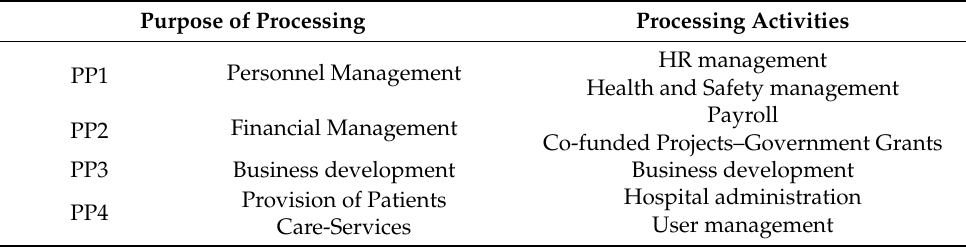
Table 1. Identified data processing activities.